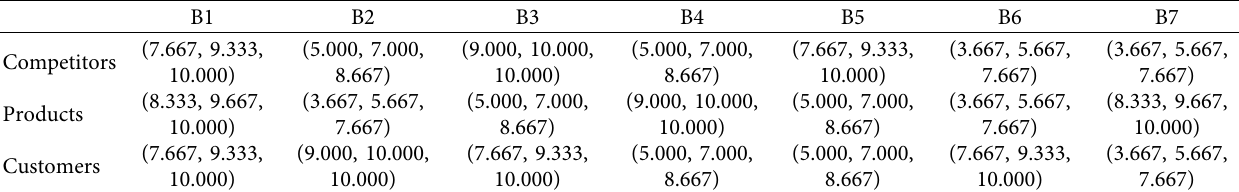
Table 11: Fuzzy decision matrix 􏽥 D